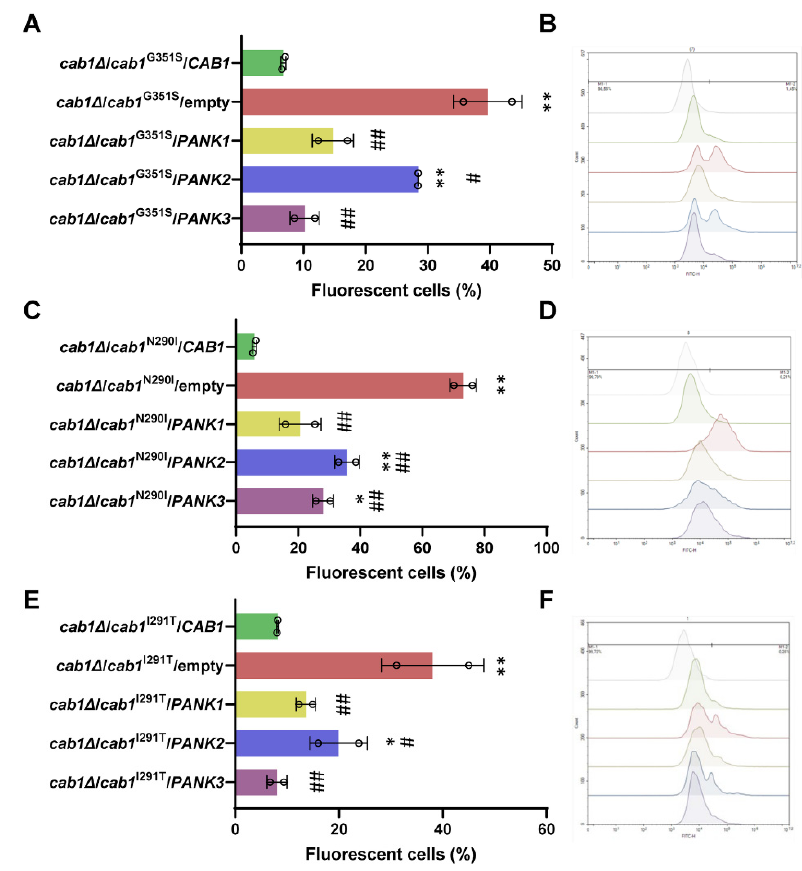
Figure 5. Analysis of reactive oxygen species (ROS) yeast PanK-deficient mutants expressing human PanK isoforms. ROS measurements were performed for cab1 ∆ / cab1 G351S ( A ), cab1 ∆ / cab1 N290I ( C ), and cab1 ∆ / cab1 I291T ( E ) yeast strains transformed with pFL38/ CAB1 , EV, and pESC- URA3 vector containing different human PanK isoforms. ROS production was determined as the percentage of fluorescent cells using the DHR123 probe. Cytofluorometry analysis of the cab1 ∆ / cab1 G351S ( B ), cab1 ∆ / cab1 N290I ( D ), and cab1 ∆ / cab1 I291T ( F ) yeast strains transformed with either pFL38/ CAB1 , empty vector or pESC- URA3 vector containing different human PanK isoforms following staining with DHR123 probe. Each curve represents the distribution of the measured events (counts) according to their fluorescence intensity expressed in a log unit. The grey spectrum represents background autofluorescence. The strains were grown in YP medium supplemented with 2% galactose at 28 ◦ C. This assay was conducted in triplicate ( n = 3) and the plotted graphs represent the average ± SEM. *: p < 0.05 and **: p < 0.01 relative to mutant strain transformed with CAB1 allele and #: p < 0.05 and ##: p < 0.01 relative to mutant strain transformed with the empty